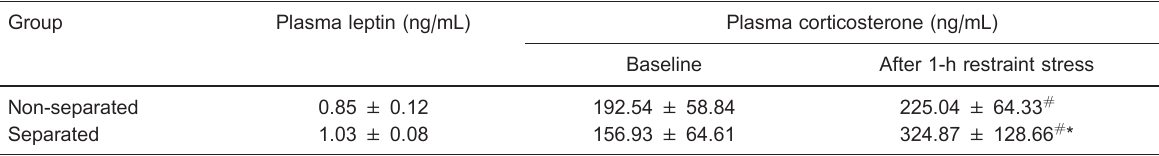
Leptin levels did not differ between separated and non-separated dams (P . 0.05, Student t -test, n = 7 dams/group). Plasma corticosterone levels were increased by exposure to stress in both groups ( # P = 0.005, two-way ANOVA, n = 6-7 dams/group), markedly in separated dams compared to non-separated dams (*P = 0.048 for the